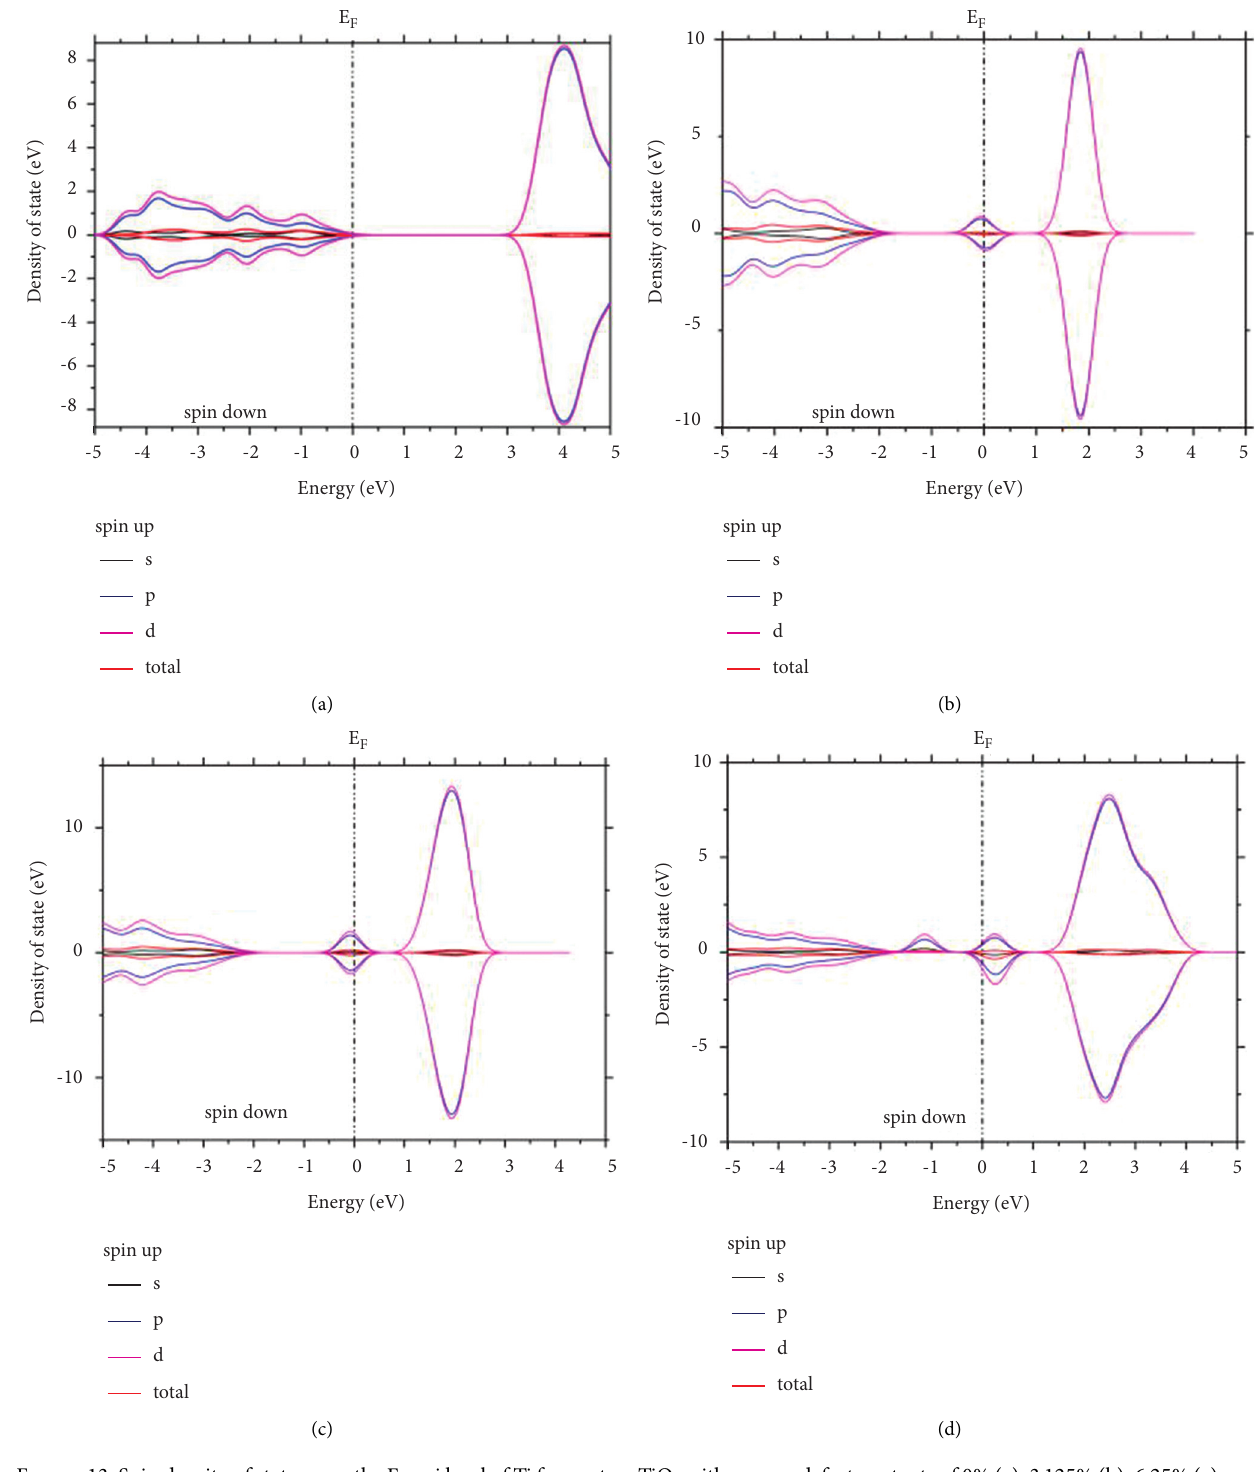
2 with oxygen defect contents of 0% (a), 3.125% (b), 6.25% (c), and